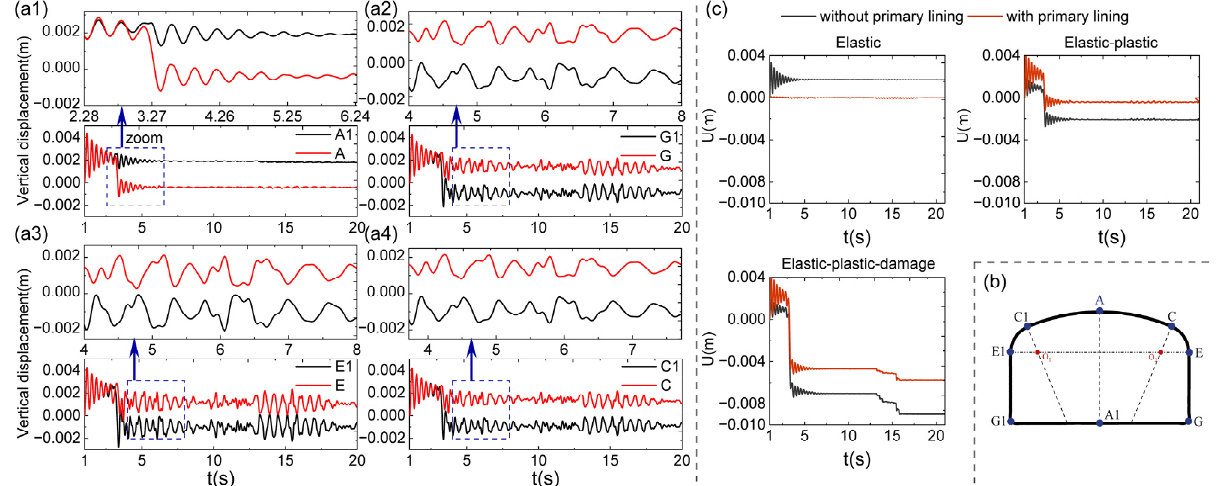
Figure 8. Vertical displacement of the tunnel with primary lining ( a1 – a4 ) time histories ( b ) monitoring stations ( c ) time histories of the vertical displacement of the tunnel crown.